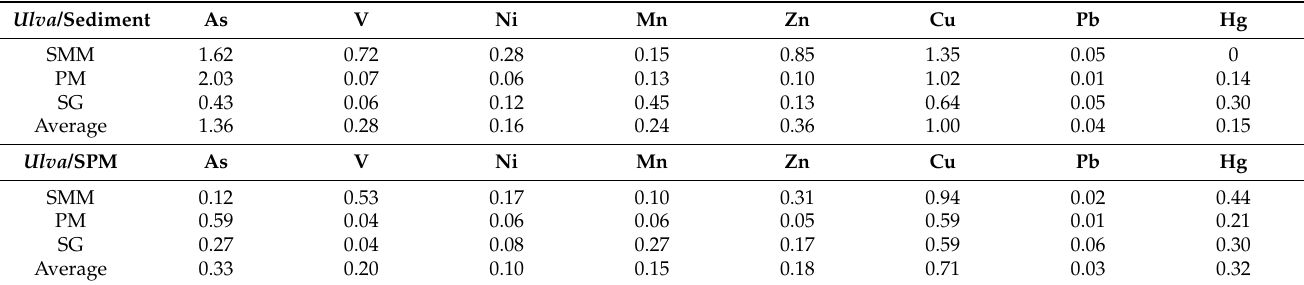
Table 3. Biota-sediment accumulation factors (BSAF) for metals of sediment and SPM in U. laetevirens collected at LV: SMM—Santa Maria del Mare; PM—Porto Marghera; SG—San Giuliano.